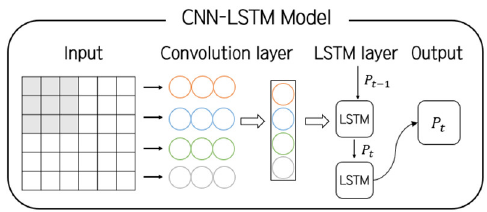
Figure 4. Value derivation method by CNN-LSTM.